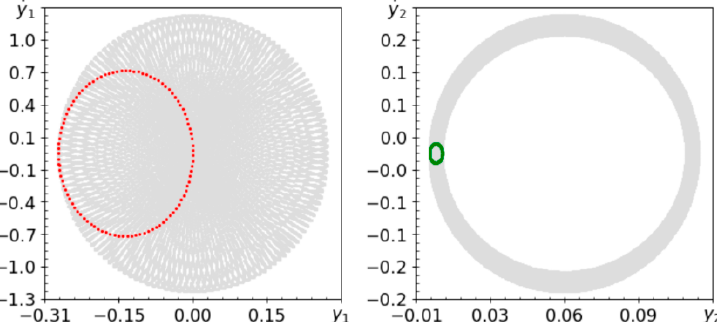
Figure 2. Phase planes (gray lines) and Poincaré maps (red and green dots) for ω = 3.64.